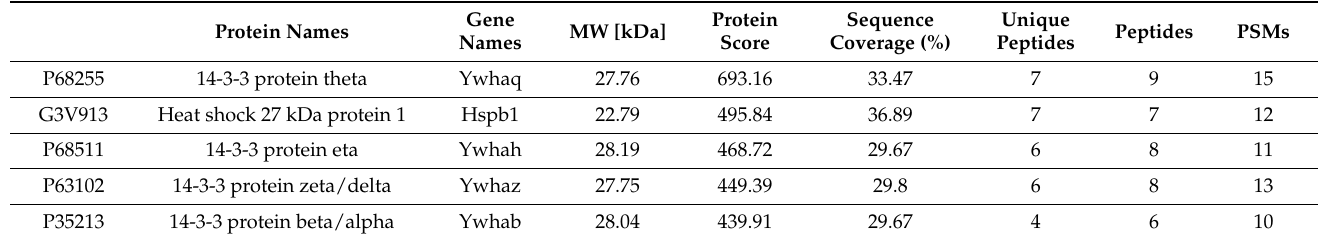
Table 2. Protein identification results of the 25 kDa band in Figure 3.